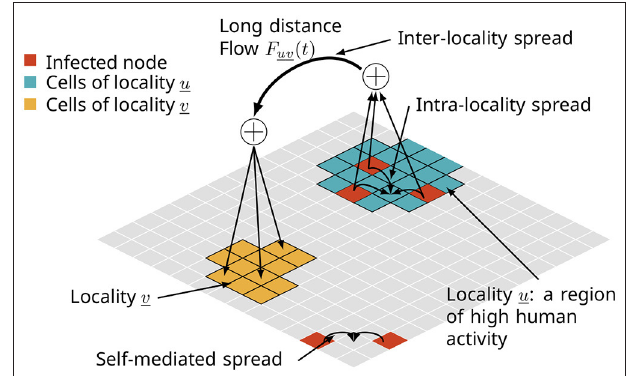
FIGURE 1 | A multi-pathway network model of a spatial diffusion process in the context of biological invasions. The spread takes place at multiple spatial scales, such as (i) one cell to adjacent cells due to self-mediated spread, (ii) within a locality of high human activity, and (iii) long distance jumps facilitated by trade and